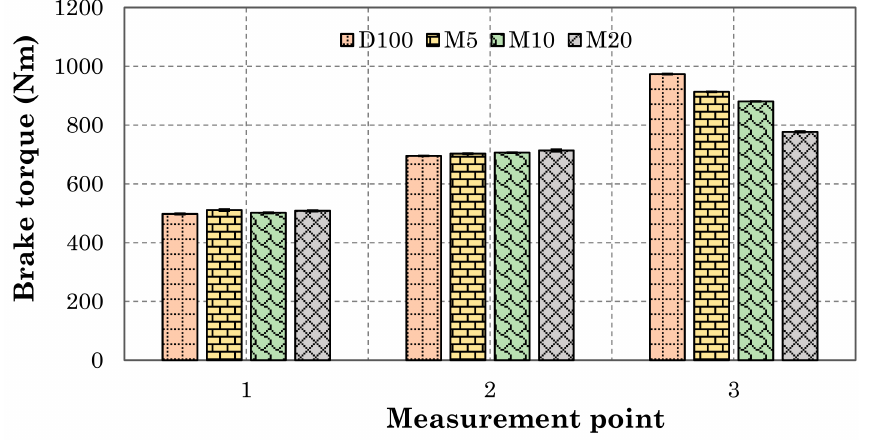
Figure 6. Brake torque for all test fuels at the measurement points (error bars represent the standard deviation).